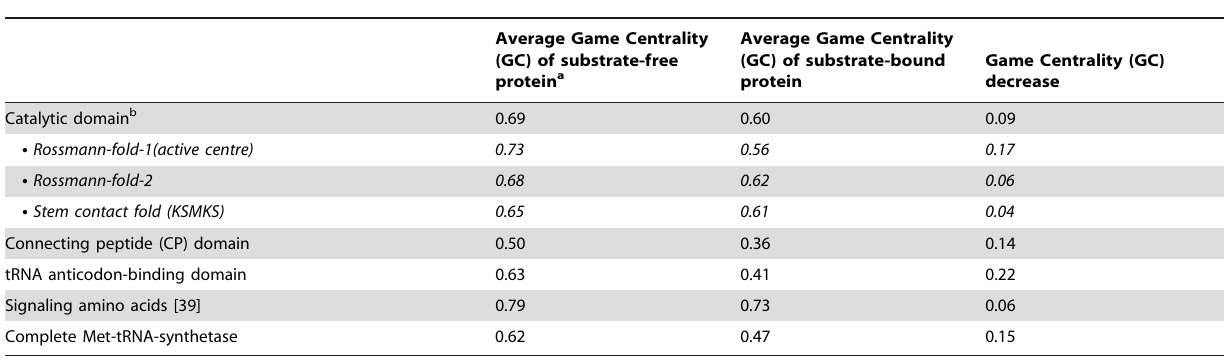
Table 3. Average game centrality (GC) values for E. coli methionyl-tRNA synthetase amino